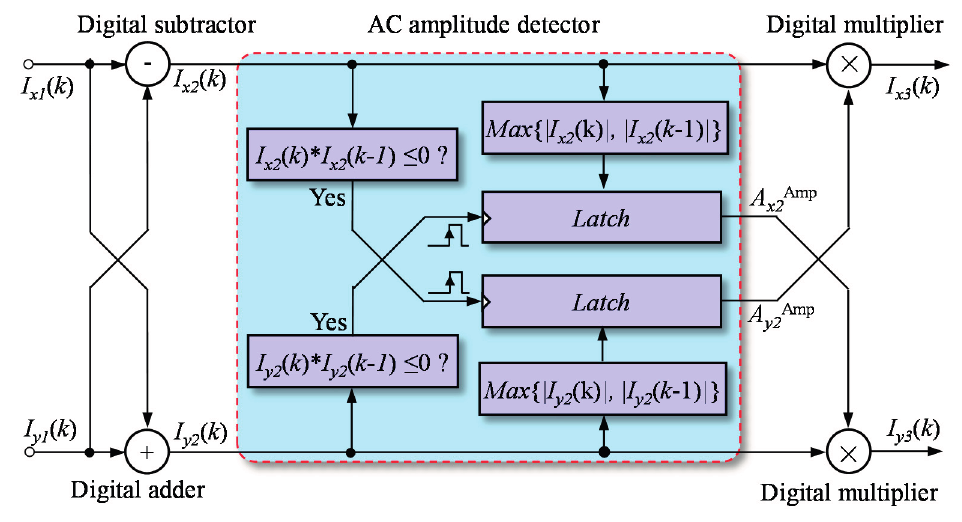
Figure 7. Correction of phase delay. The phase delay error was corrected through vector subtraction and summation operations, and the amplitude correction module was utilized to balance the difference in amplitude resulting from the vector subtraction and